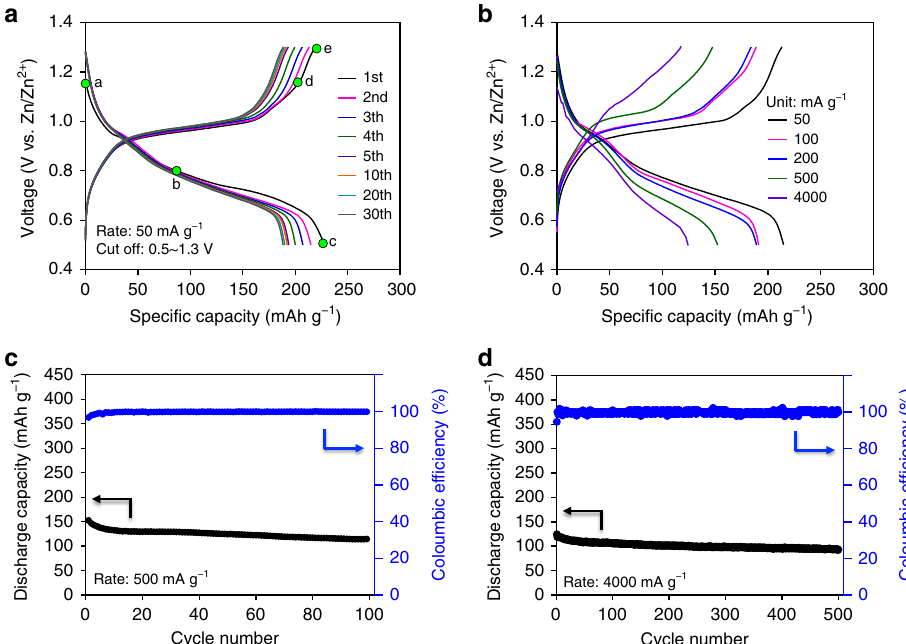
Fig. 3 Electrochemical performance of Cu 3 (HHTP) 2 . a , b Discharge – charge voltage pro fi les of Cu 3 (HHTP) 2 at a 50 mA g − 1 and b various current densities. The green dots labeled with (a – e) in ( a ) are states where XPS analysis in Fig. 4b, c was conducted. c , d Cycling performance of Cu 3 (HHTP) 2 at current densities of c 500 mA g − 1 and d 4000 mA g − 1